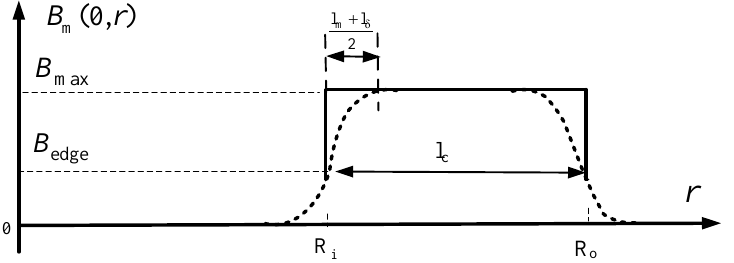
Figure 13. Approximate distribution of the magnetic flux-density produced by permanent magnets in the middle of the air gap ( z = 0) along coordinate “ r ” for θ − ϕ = 0 .